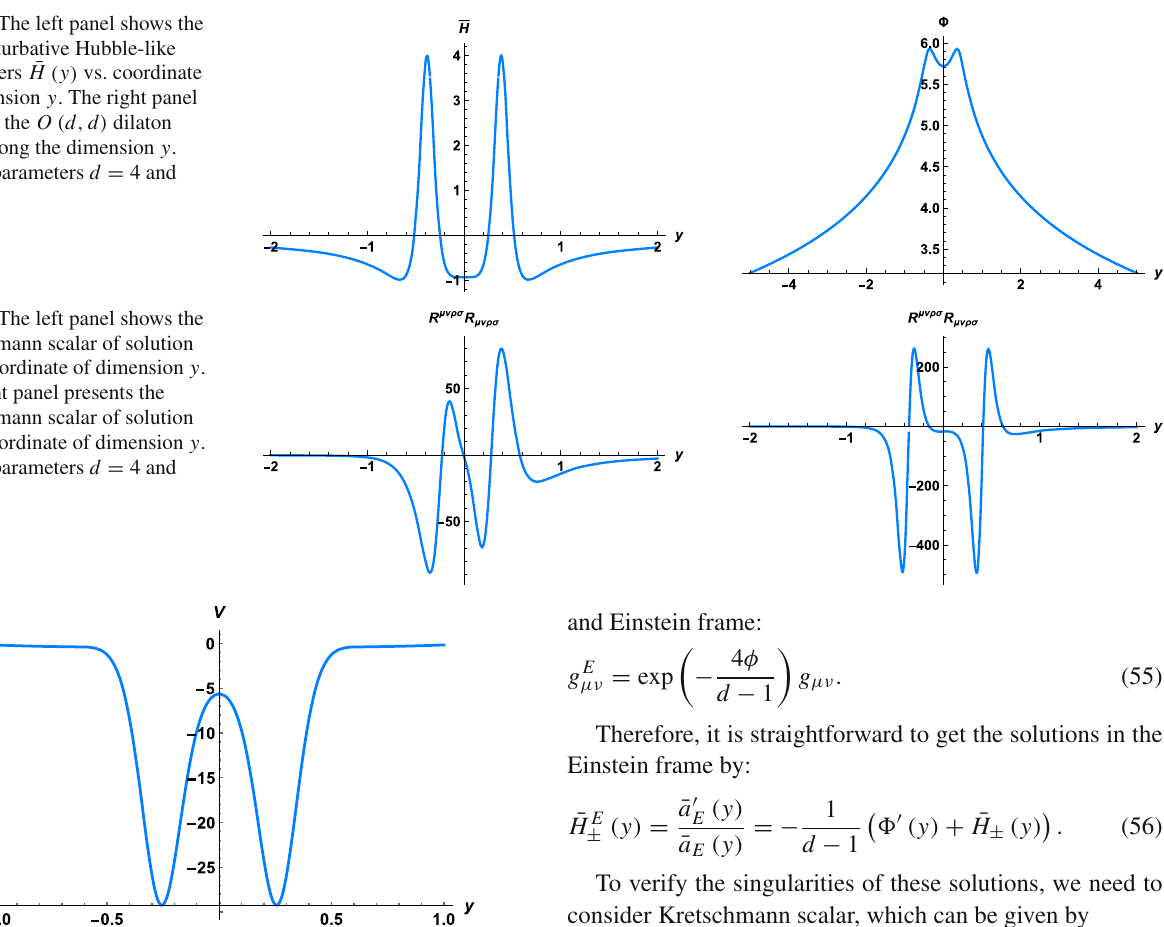
Fig. 3 The left panel shows the non-perturbative Hubble-like parameters ¯ H ( y ) vs. coordinate of dimension y . The right panel presents the O ( d , d ) dilaton (cid:7)( y ) along the dimension y .